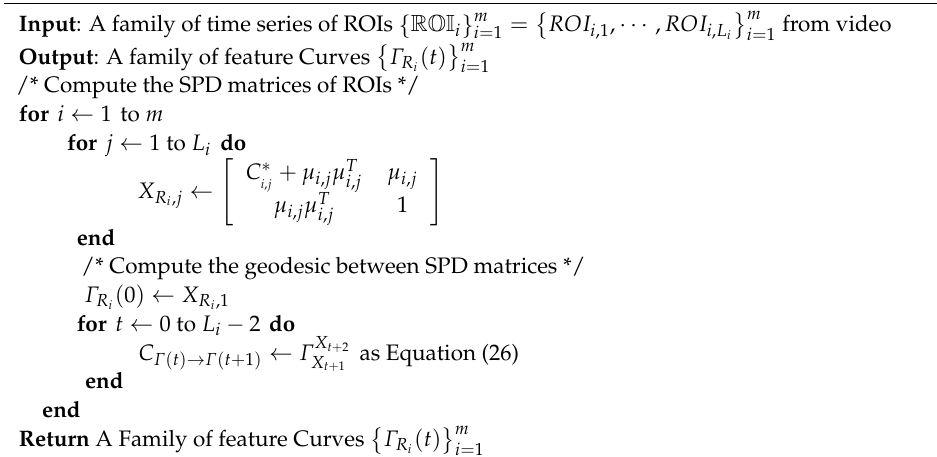
(cid:8) ( t ) (cid:9) m Γ R on Sym D + 1 i = 1 i